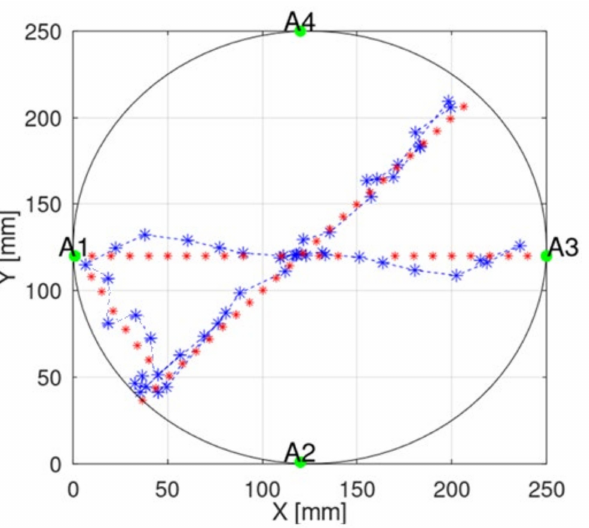
Figure 15. The example of implemented measurement scenario presented in the cross-section of a physical model. Red markers indicate true capsule positions, blue markers indicate estimated positions and A1–A4 indicate external